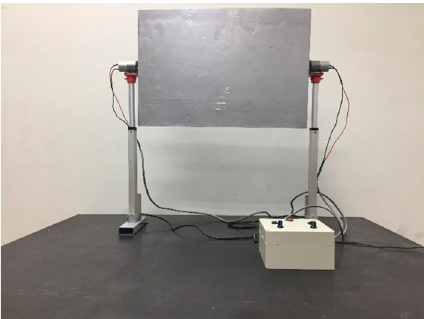
Figure 10: Move the frame vertically to the top